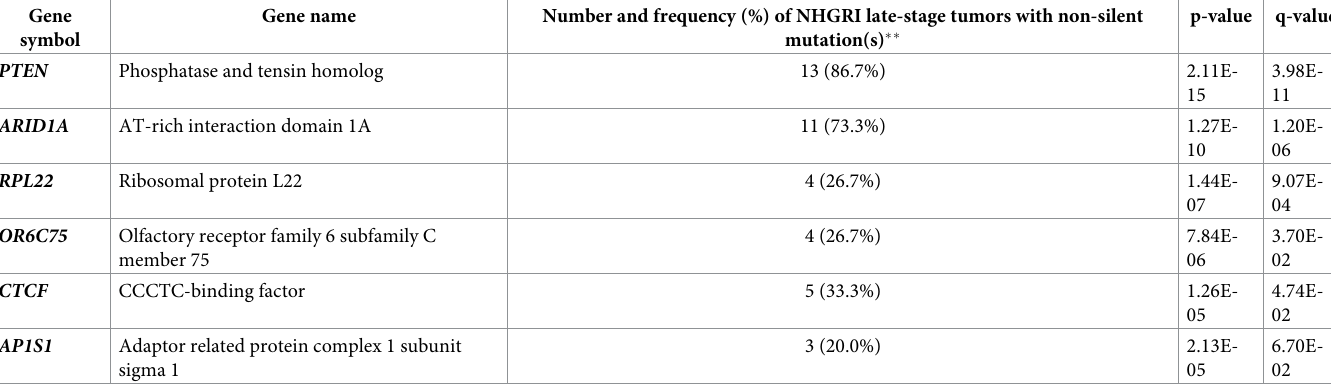
Table 1. SMGs (q � 0.10) identified within the NHGRI cohort of 15 late-stage EEC exomes. Gene